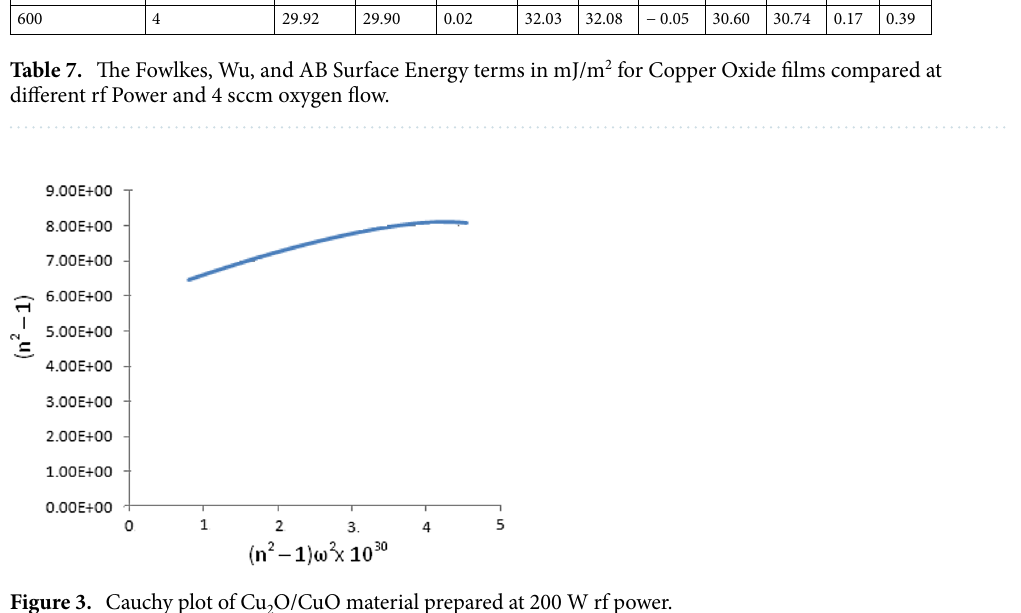
Figure 3. Cauchy plot of Cu 2 O/CuO material prepared at 200 W rf